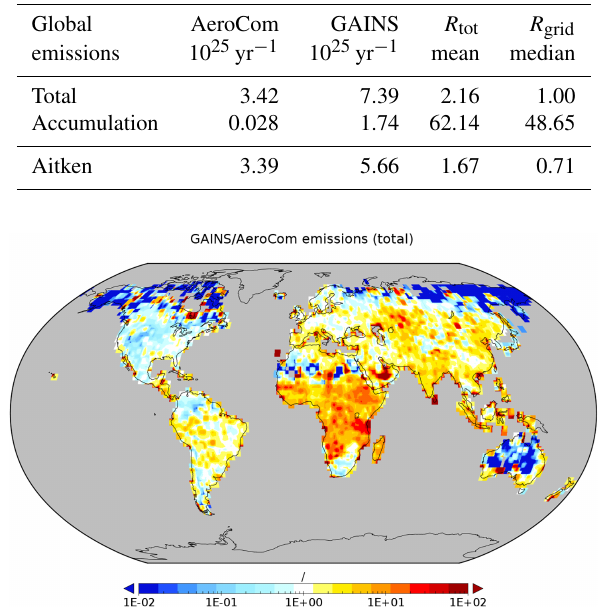
Figure 2. GAINS / AeroCom ratio for annual anthropogenic parti- cle number emissions.